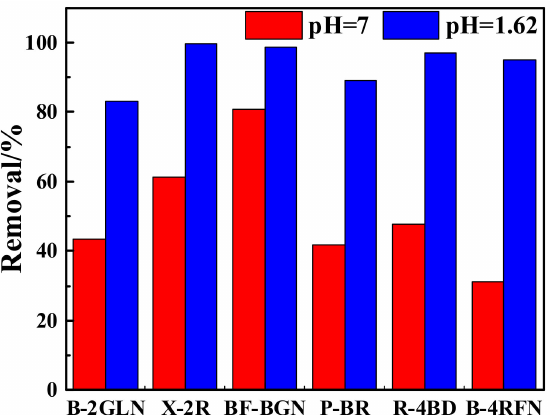
Figure 11. The adsorption performance of carbon-supported metal nickel on various dyes under neutral conditions and pH =